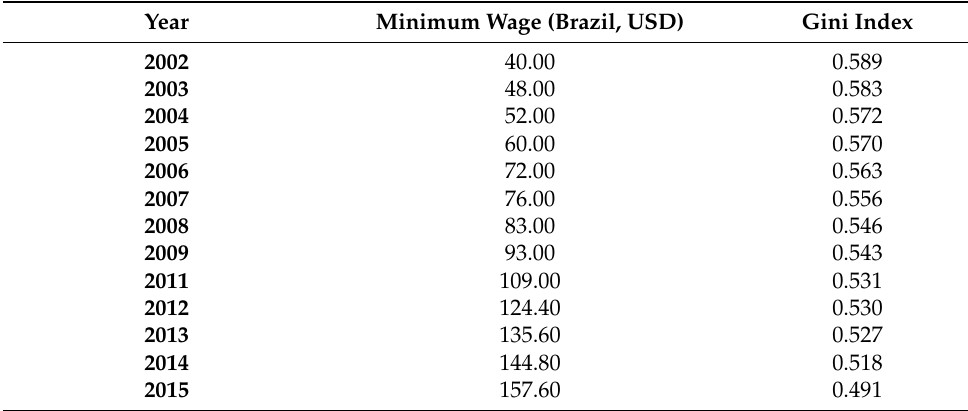
Table 4. The actual Brazilian minimum wage and Gini index.